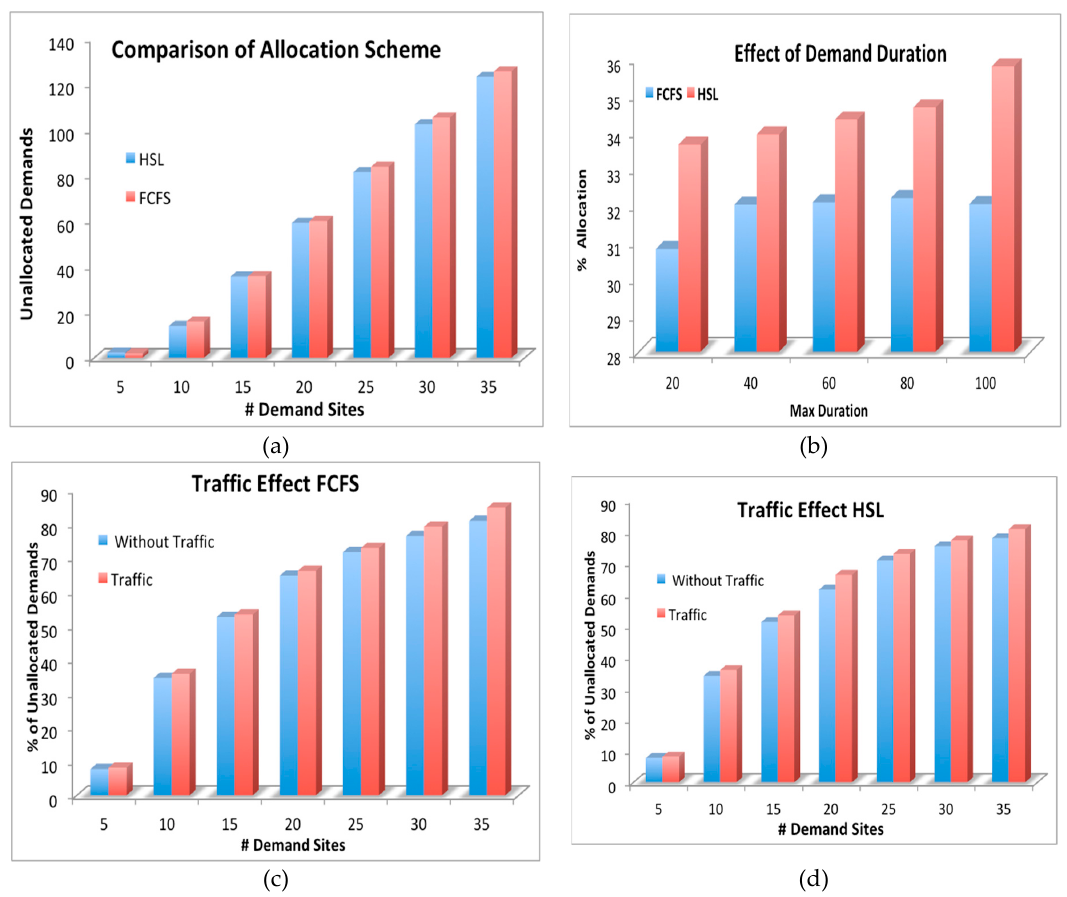
Figure 7. Effect of number of demand sites on total unallocated demands. ( a ). Percentage of allocated demands w.r.t duration of commitment demands ( b ). Effect of traffic on % of unallocated demands (first come first serve—FCFS) ( c ). Effect of traffic on % of unallocated demands (high severity level—HSL) ( d ).